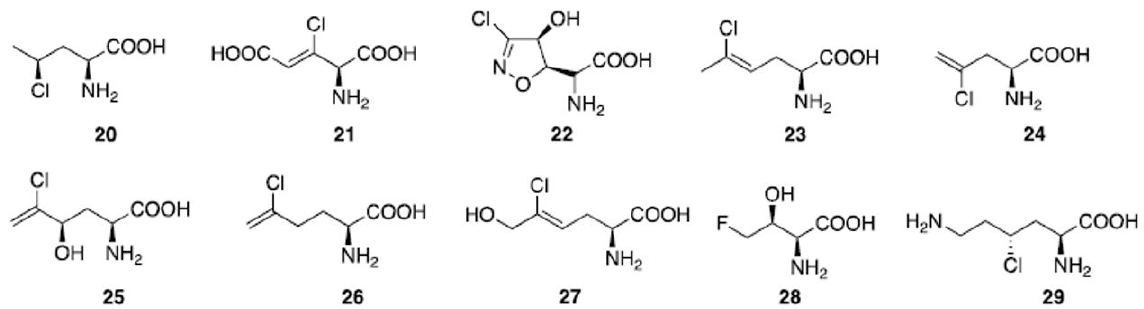
Figure 6. Natural aliphatic halogenated amino